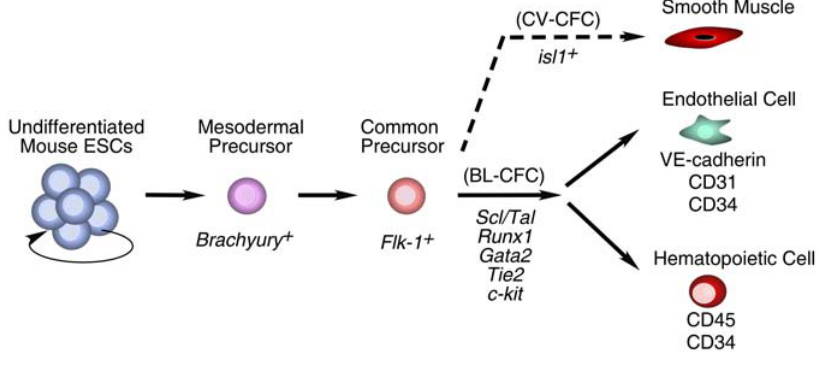
FIGURE 1. Proposed mouse developmental hierarchy of mesodermal cells . A subset of Brachyury positive cells, expressing Flk-1, emerges during mesodermal specification of differentiating mESCs. These Flk-1 + cells are capable of giving rise to BL-CFCs, which can further develop into hematopoietic and endothelial cells, as well as smooth muscle cells. Consequently, the BL-CFC has been proposed to represent an in vitro equivalent of the hemangioblast. Furthermore, the same subset of Flk-1 + cells can also give rise to CV-CFCs, which are endowed with cardiac and vascular potential. These CV-CFCs emerge later and are distinct from the BL-CFCs. Collectively, the BL- and CV-CFC may represent a transient precursor population, capable of commitment to the hematopoietic, endothelial, smooth muscle, and cardiac lineages dependent on the temporal developmental expression and activation of different transcription factors (such as Scl/Tal1, Runx1, Gata2, Tie2, c-kit, and isl, respectively). Signaling molecules and transcription factors are indicated in italics , whereas cell surface proteins are indicated in plain